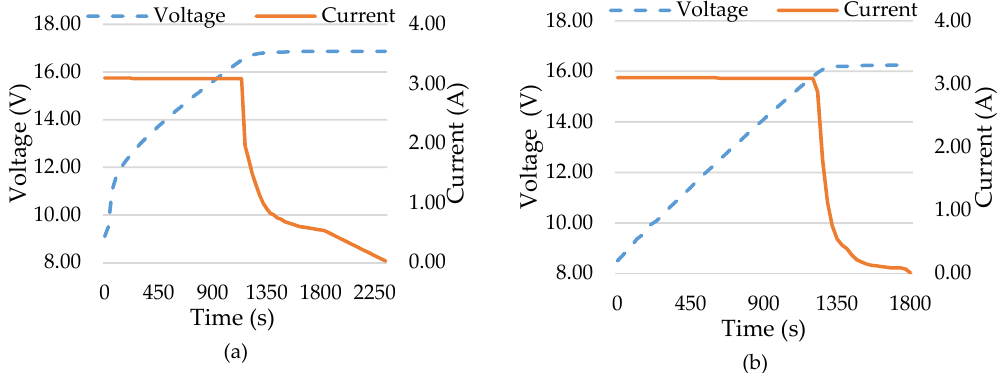
Figure 7. The experimental validation of the charging of ( a ) HC and ( b ) SC under a 3-A source.